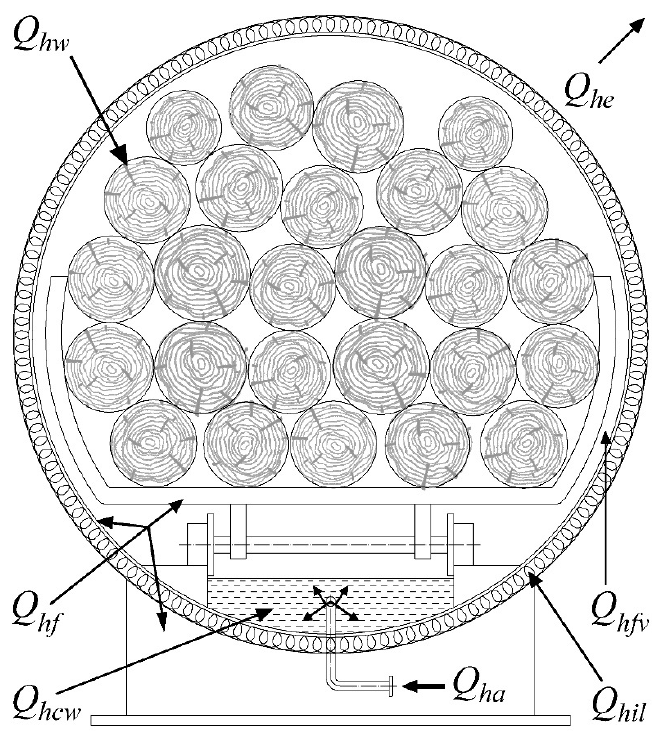
Figure 2. Structural model of the heat distribution in an autoclave for steaming of